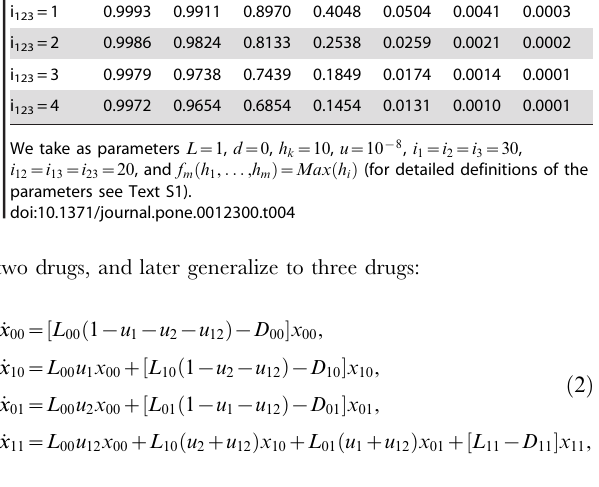
Algorithm A1 for finding the best treatments in the case